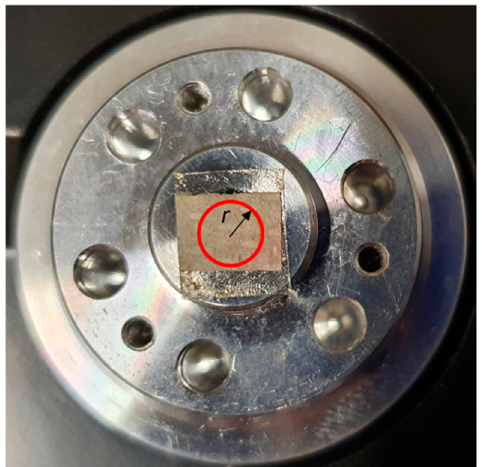
Figure 4. The spinning-cell setup. The substrate is mounted at the center of the rotating device and the laser is kept fixed at distance r from the rotation axis. During the SERS measurement, the laser track on the substrate follows the annular surface highlighted in red.